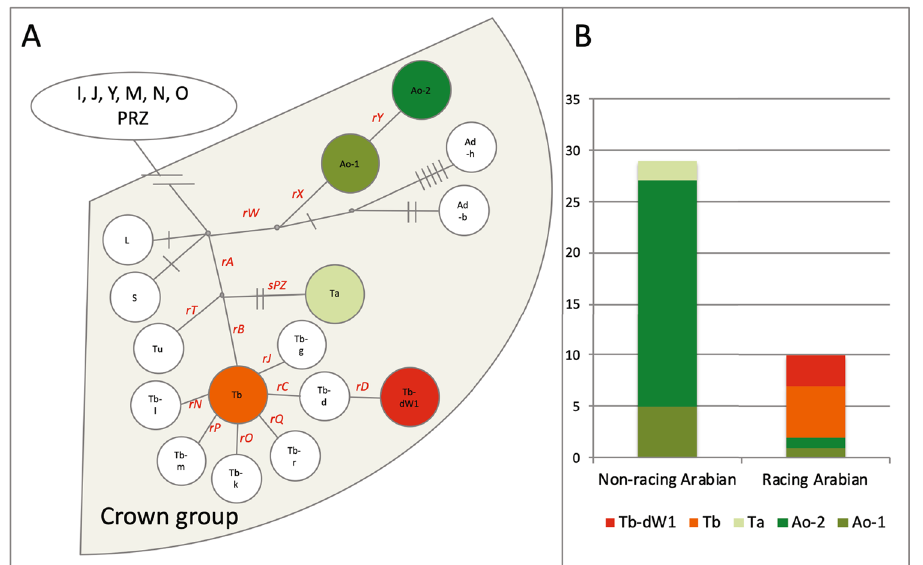
Figure 5. Y chromosome haplotyping supports use of Thoroughbred sire lines in the Racing Arabian subgroup. ( A ) Reduced haplotype network map of the male-specific region of the Y-chromosome according to 21 with SNPs genotyped in this study in red. Detected haplotypes are colored, and haplotypes in white circles were not detected in the 39 Arabian males genotyped. Haplotypes in green were previously detected in Arabian horses in other studies 21,28 . The ‘Whalebone’ haplotype, Tb-dW1, is colored in red. ( B ) Y haplotype frequencies in racing versus non-racing Arabian horses shown in absolute